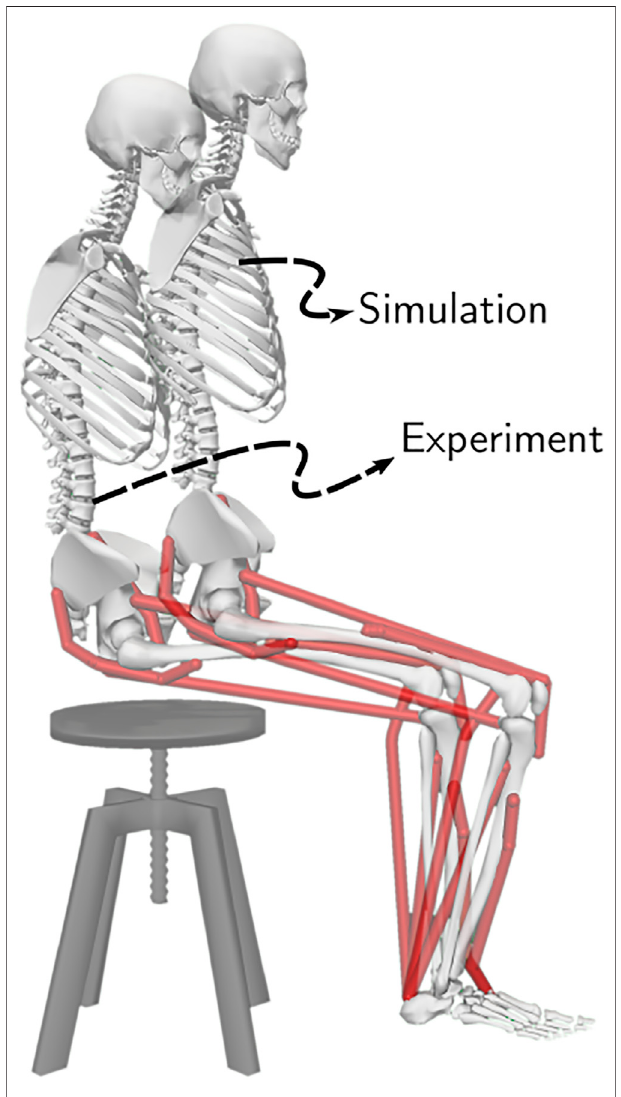
FIGURE 5 | The initial posture used to generate STS trajectories and the mean initial posture observed during experiments. The model was